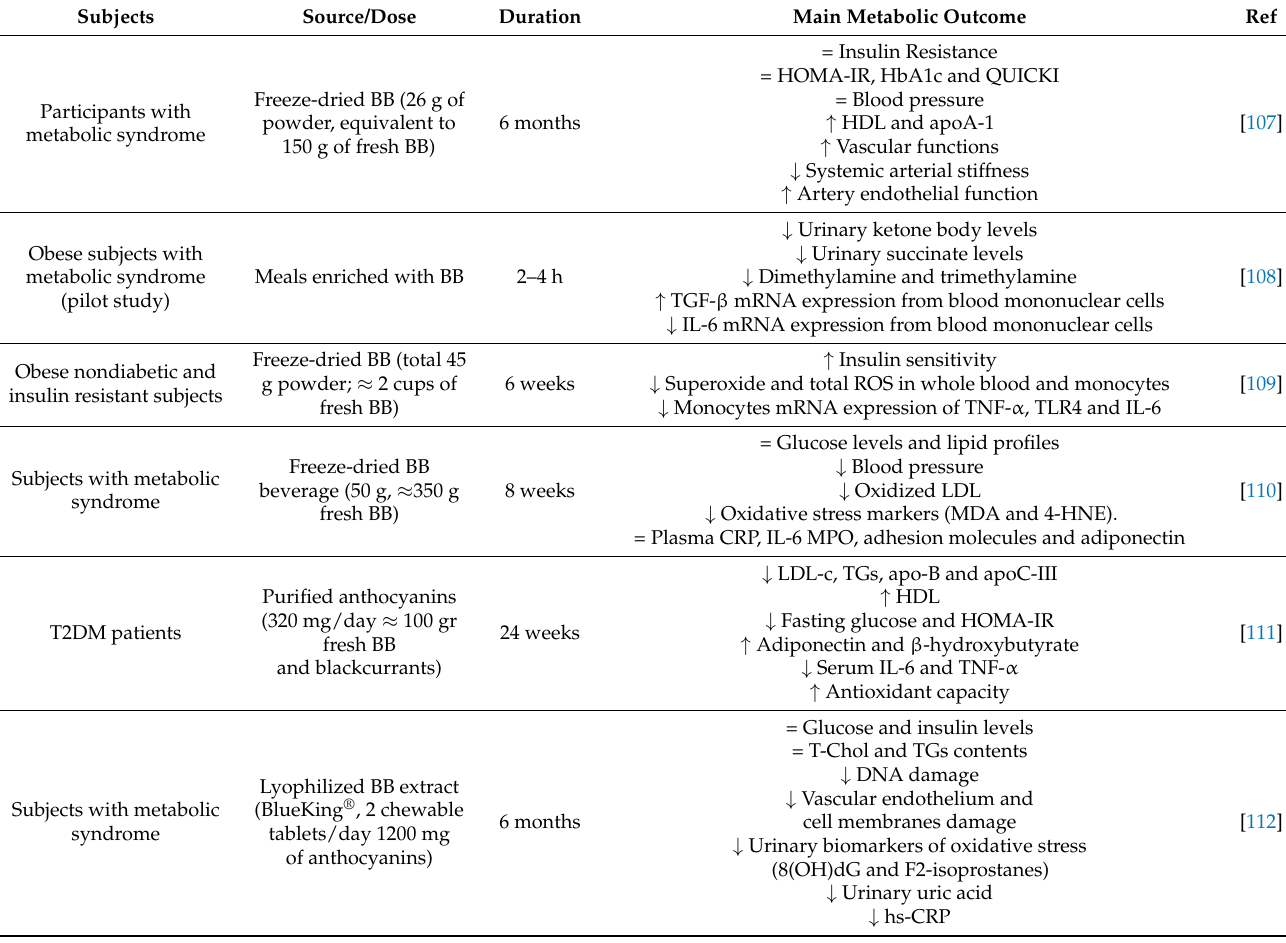
Table 1. Blueberries effects on biomarkers relevant to T2DM and associated metabolic disorders—clinical